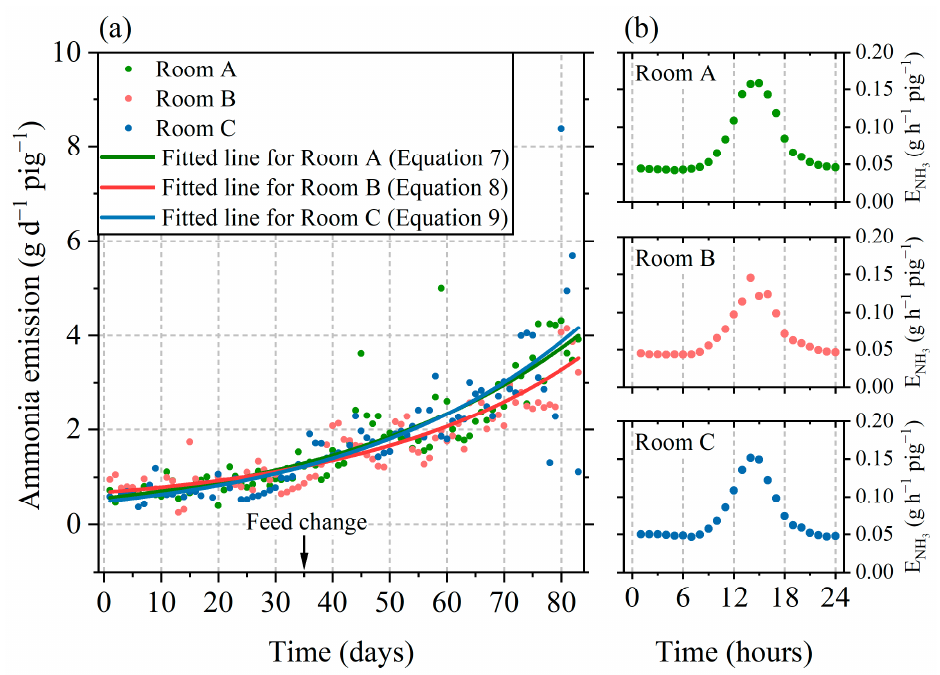
Figure 5. ( a ) Time–series graphs of daily ammonia emission in Rooms A to C and their exponential fitted lines and ( b ) diurnal graph of hourly ammonia emissions in Rooms A to C.